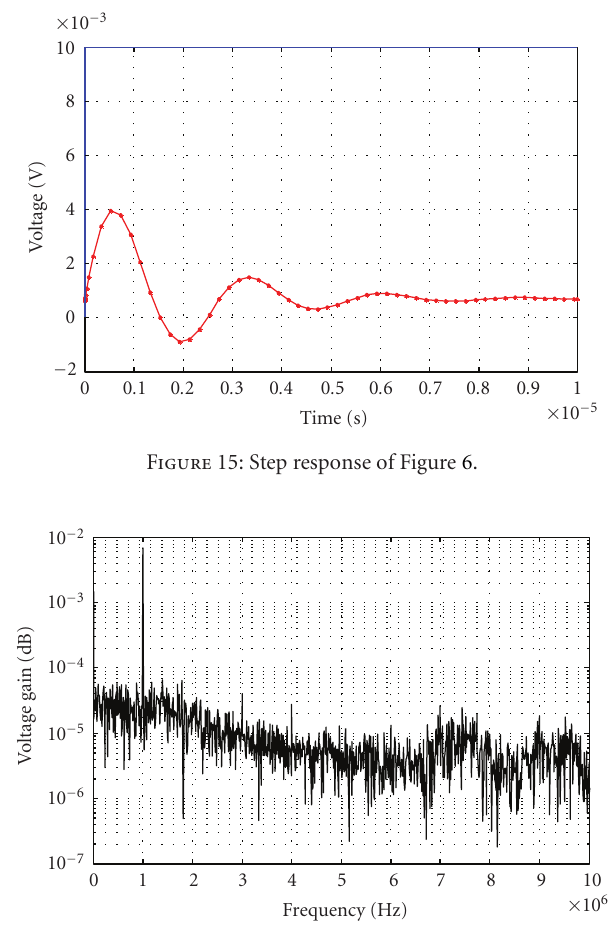
Figure 16: Simulated spectrum of the output signal Vo in Figure 6.